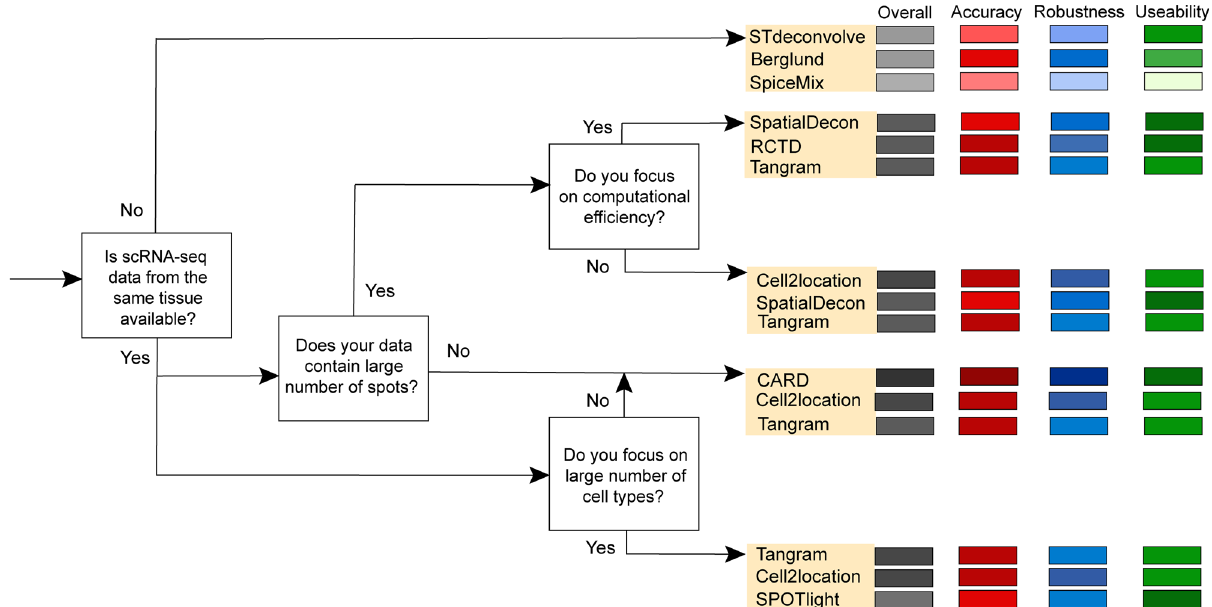
Fig. 4 | Scenario-speci fi c decision-tree-style guidelines for users. Four common scenarios are included, and three methods are recommended for each